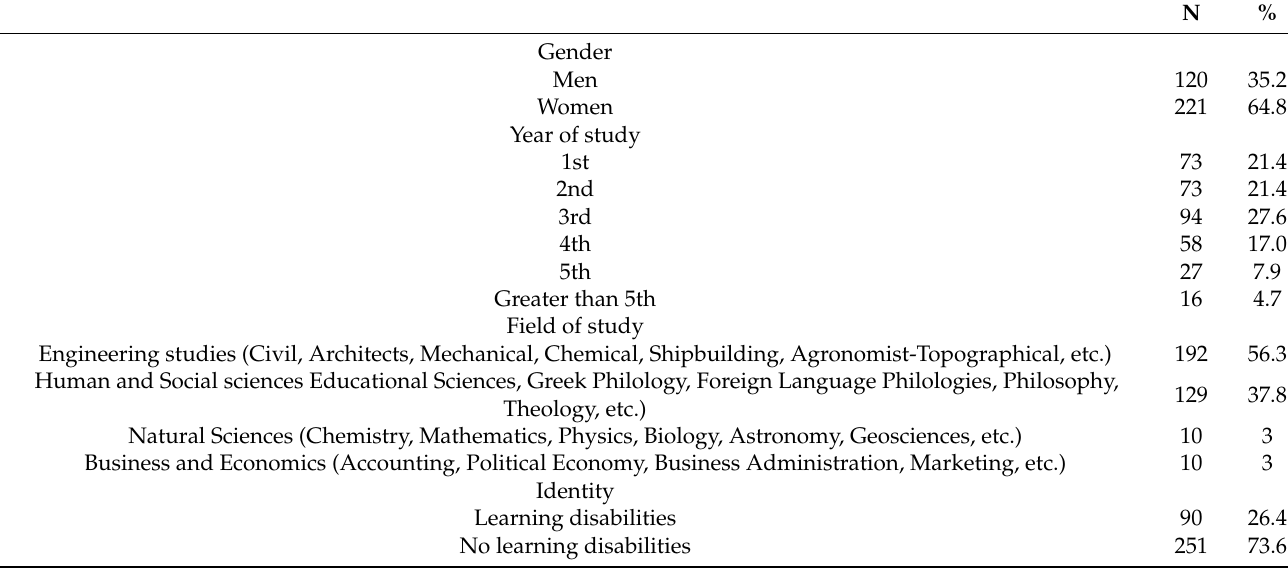
Table 1. Basic demographic characteristics of the